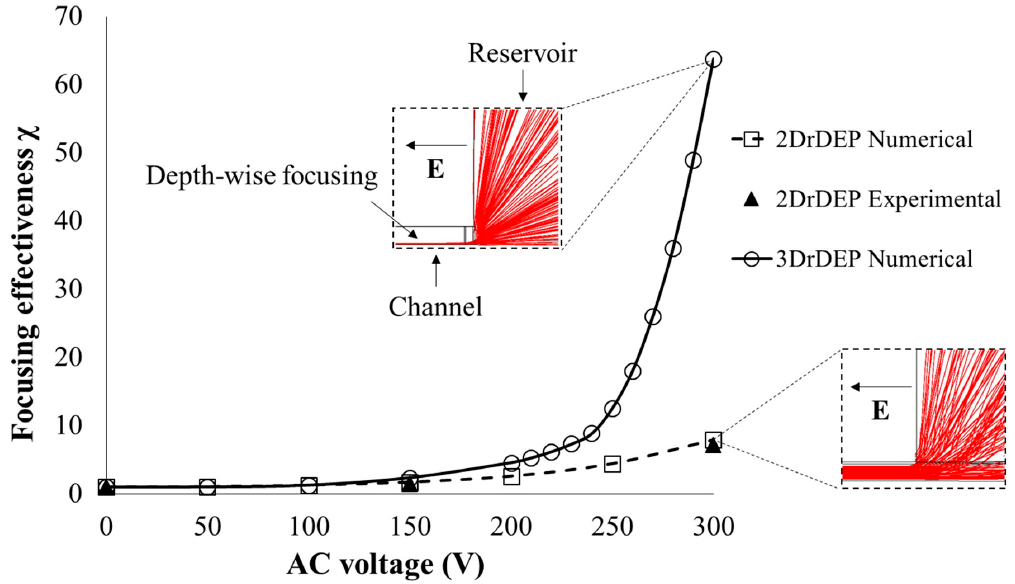
Figure 4. Graphical representation of the variation of the dimensionless focusing effectiveness, χ (defined in Equation (6)), as a function of the applied AC voltage in the 2DrDEP and the 3DrDEP devices. The applied DC voltage is fixed at 25 V, while the AC voltage is varied from 0 V to 300 V. Numerically predicted 5 µm particle path-lines are used to measure the width and depth of the focused particles and the measurements are used in Equation (6) to calculate the effectiveness. Three experimental data points corresponding to the images in Figure 3a, are also shown for comparison with the numerical graphs for 2DrDEP. These experimental data points are obtained by measuring the experimentally generated streak width of the beads in the top view (X-Y), and recalling that the depth of this focused streak is equal to the channel height due to the 2D electric field gradients. The measured streak widths are then substituted in Equation (6) to obtain the focusing effectiveness. The inset images represent the numerically predicted path-lines for 25 V DC/300 V AC plotted in the side view (X-Z). Observe the significant increase in the focusing effectiveness of the 3DrDEP device over the 2DrDEP device because of the strong additional depth-wise component of the electric field gradients produced in the former.